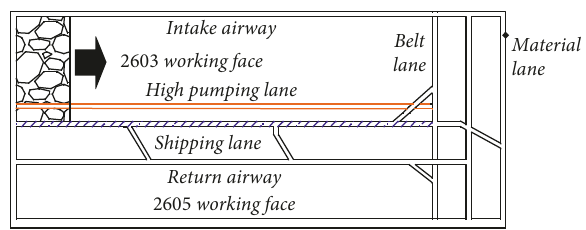
Figure 2: 2603 working face.